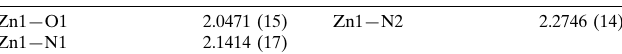
Selected bond lengths (A˚ ).